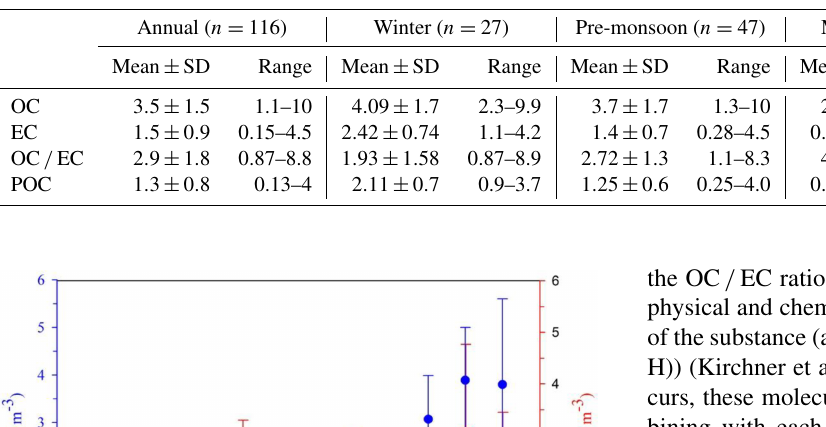
Table 2. Statistical results of EC, OC, and POC concentrations (µgm − 3 ) and the OC / EC ratios in aerosol from GHZ during December